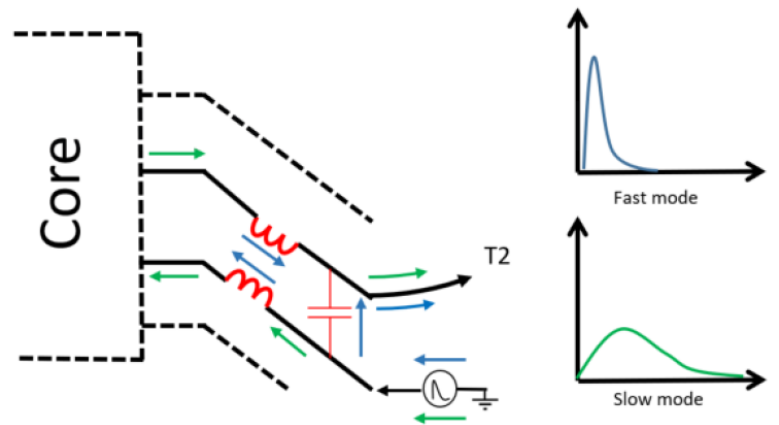
Figure 17. Capacitive and inductive coupling between bus